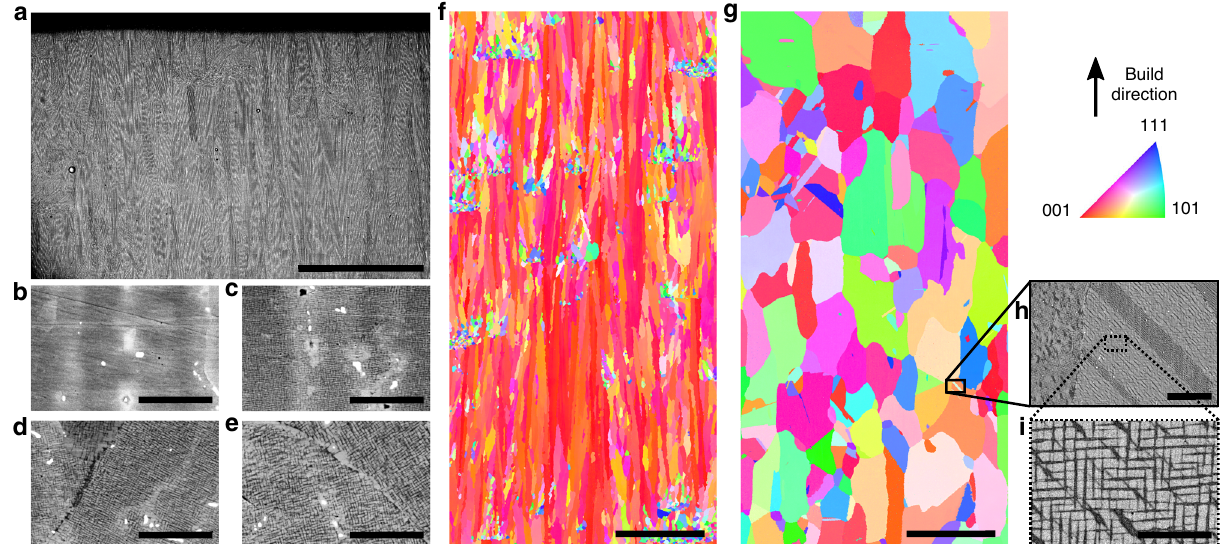
Fig. 4 EBM microstructural evolution before and after post-processing. a Stitched BSE image of the fi nal build layers in as-printed EBM SB-CoNi-10. BSE micrographs of the as-printed EBM alloy at different depths below the fi nal build layer: b near the fi nal build layer, c 1 mm below, d 2 mm below, and e 4 mm below. f IPF map of the as-printed EBM alloy and g IPF map of the HIP + SHT + aged material. Both EBSD scans were acquired at a similar distance from the fi nal build layer (~22 mm) that is representative of the center of the tensile specimen gauge sections. h , i Additional BSE micrographs of the γ (cid:1) γ 0 microstructure after post-processing. The scale bar for a is 500 μ m. The scale bars for b – e are 5 μ m. The scale bars for f and g are 500 μ m. The scale bar for h is 25 μ m. The scale bar for i is 5 μ m.